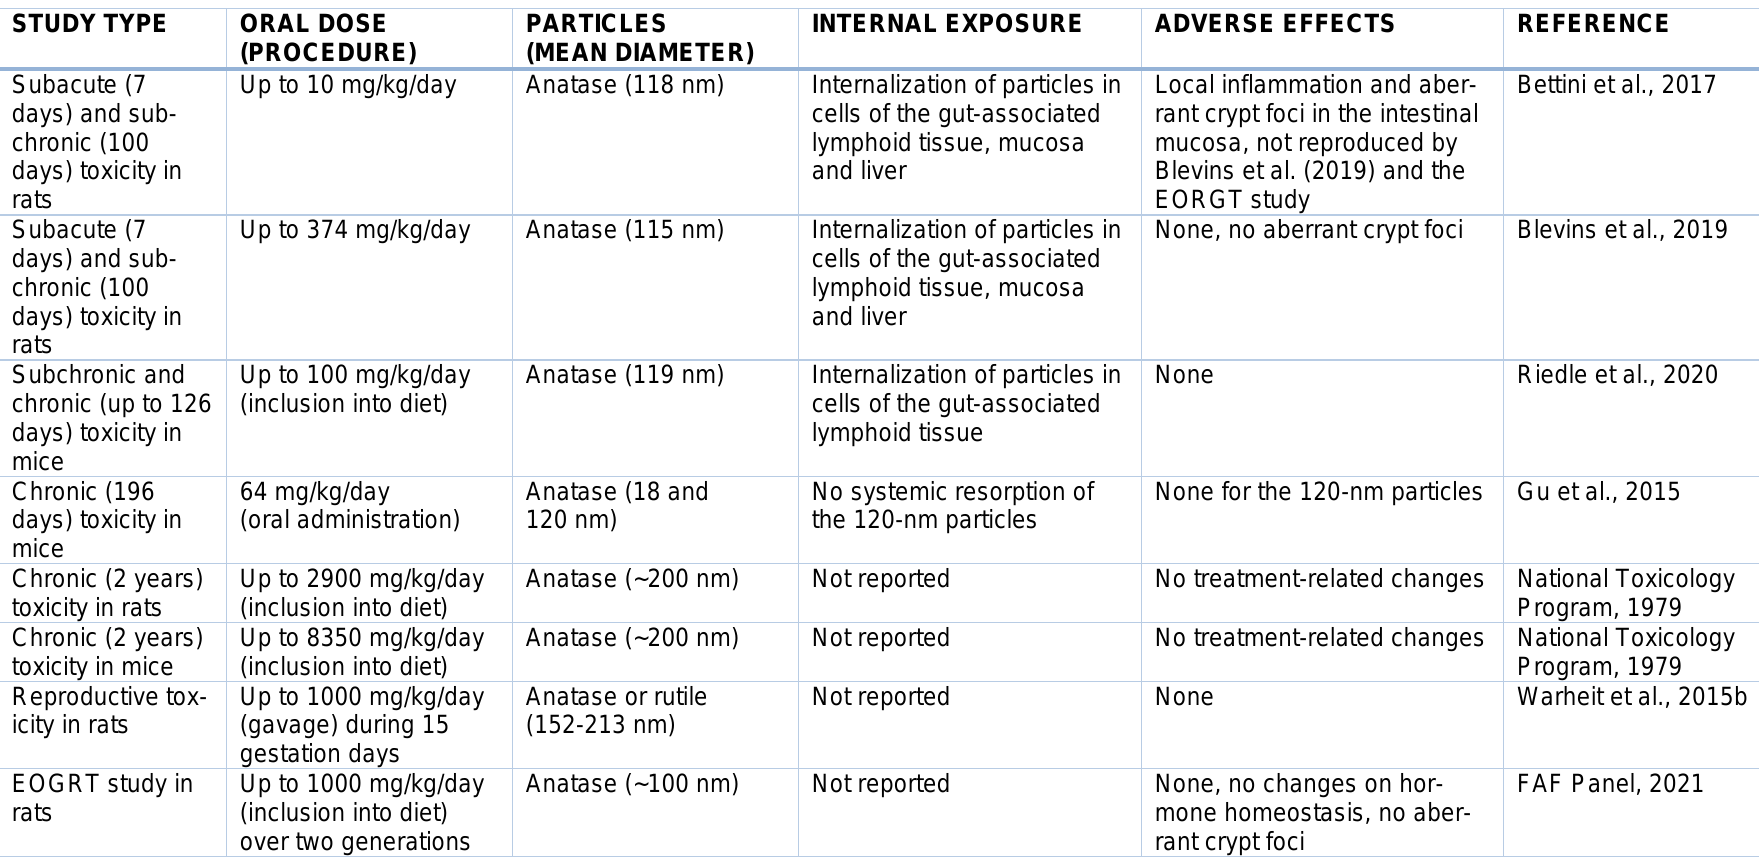
Table 2 (cont.): Overview of oral toxicokinetic and toxicodynamic studies in rodents relevant for the risk assessment of